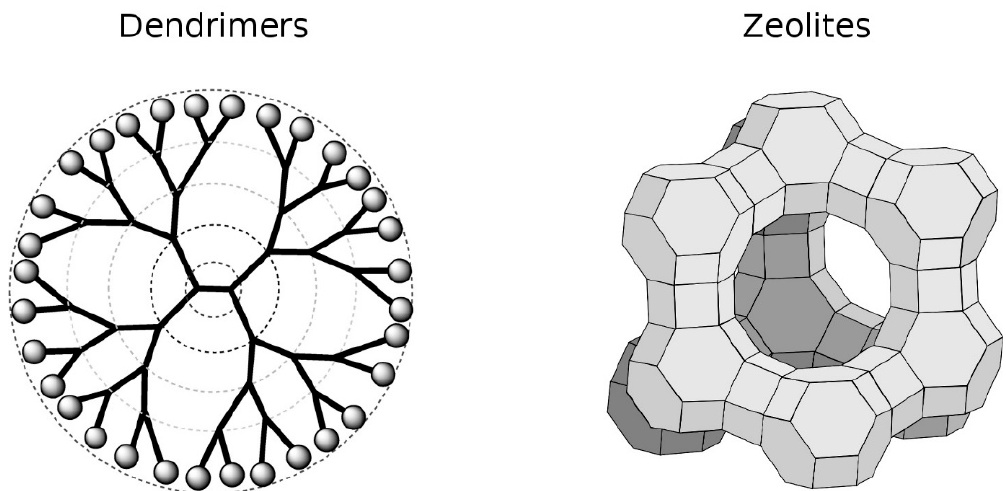
Figure 4. Selected nanomaterials currently being evaluated as functional materials for water purification [97].